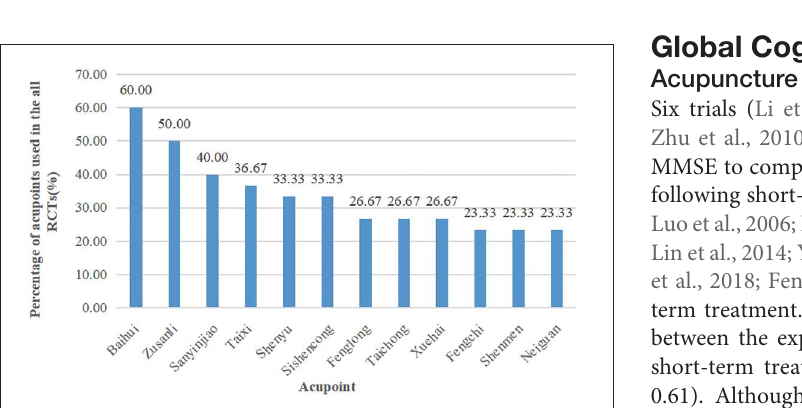
FIGURE 2 | The acupoints commonly used in the all